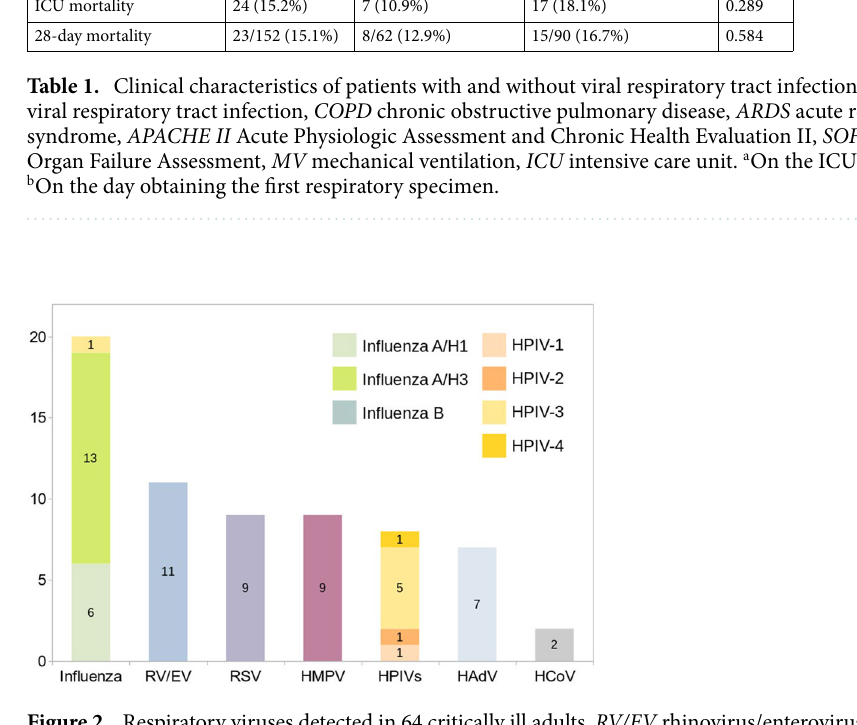
Figure 2. Respiratory viruses detected in 64 critically ill adults. RV/EV rhinovirus/enterovirus, RSV respiratory syncitial virus, HMPV human metapneumovirus, HPIV human parainfluenza virus, HAdV human adenovirus, HCoV human